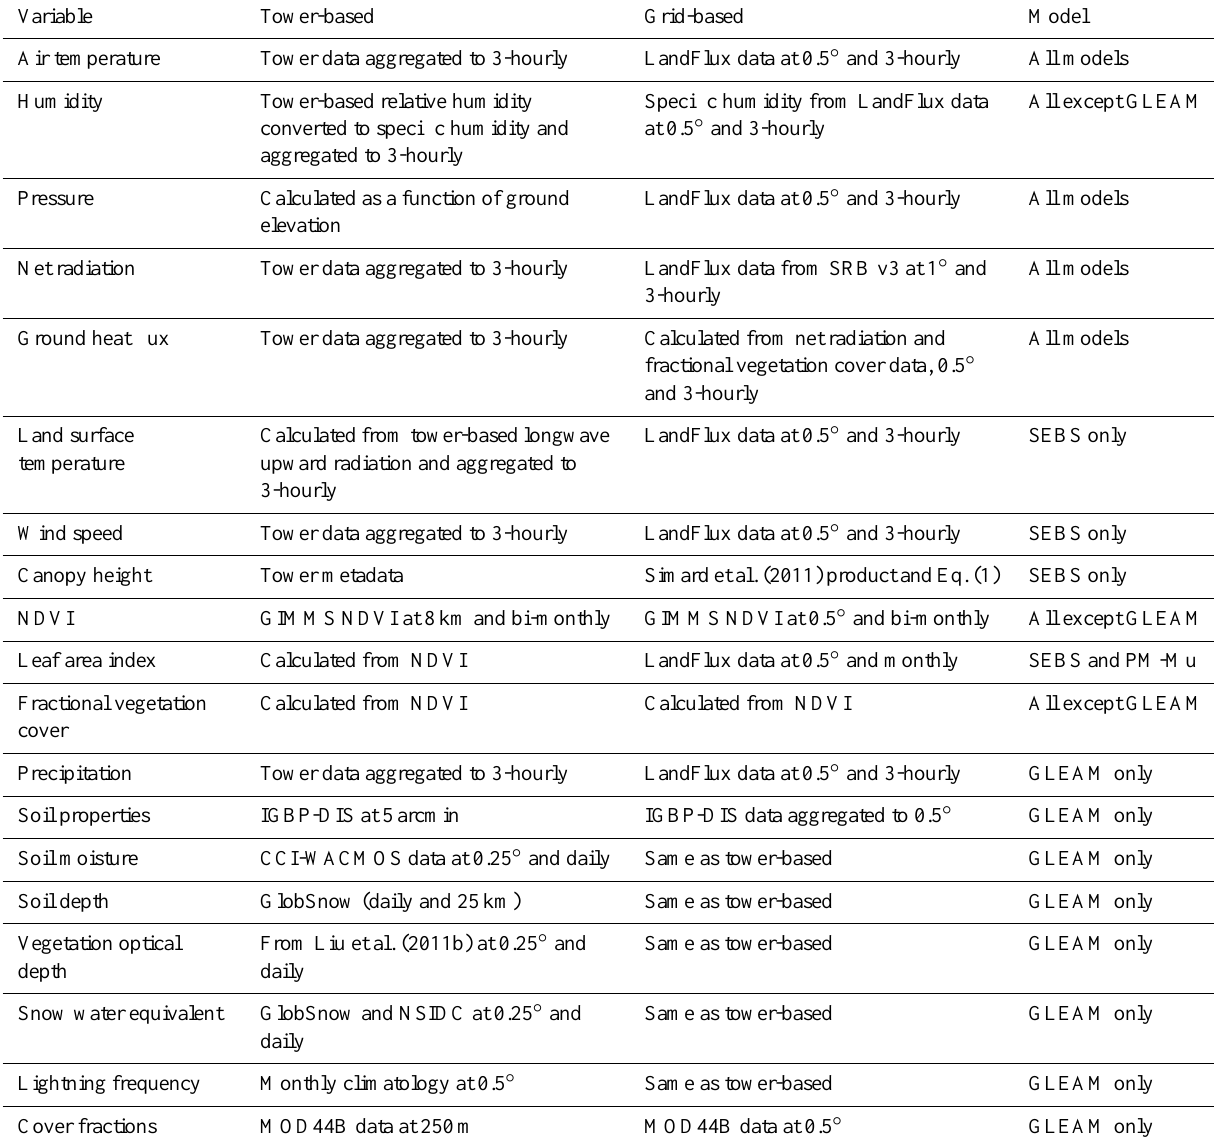
Table 1. Summary of data sources for tower-based and grid-based analysis and their spatial and temporal